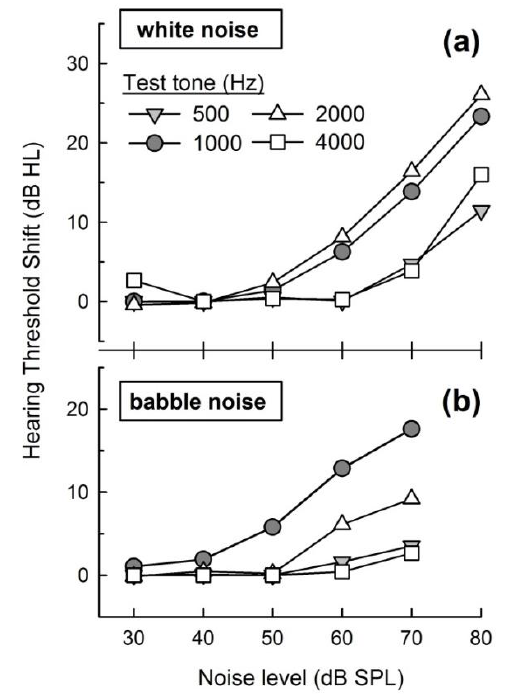
Figure 5. Mean of the hearing threshold shift for a tone (500, 1,000, 2,000, and 4,000 Hz) in the presence of environmental white ( a ) and babble ( b )